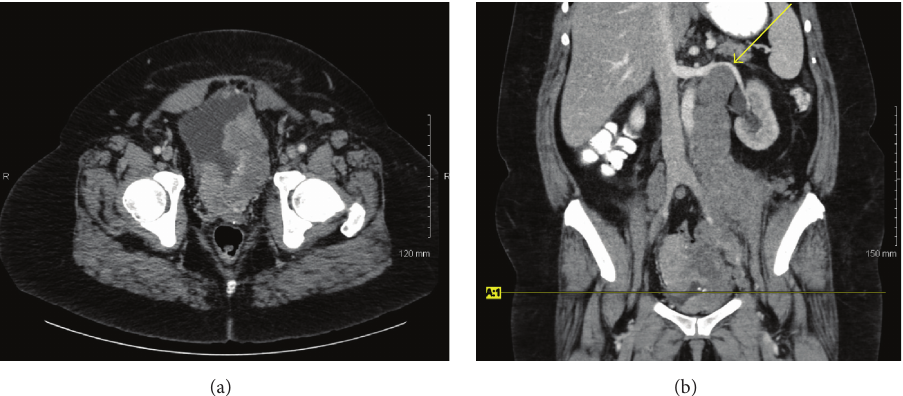
Figure 1: Axial (a) and coronal (b) pelvic CT scan images showing bladder wall thickening and retroperitoneal masses displacing left renal vein (arrow). The axial image in (a) is at the level of the horizontal line noted in (b).